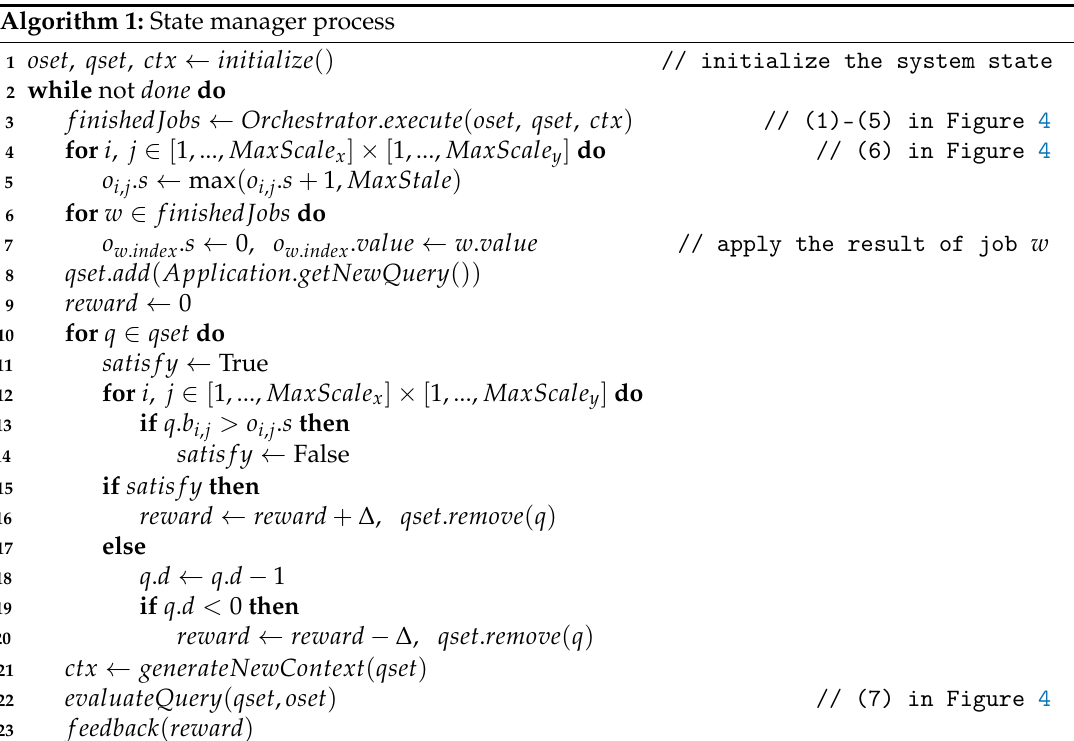
Algorithm 1: State manager